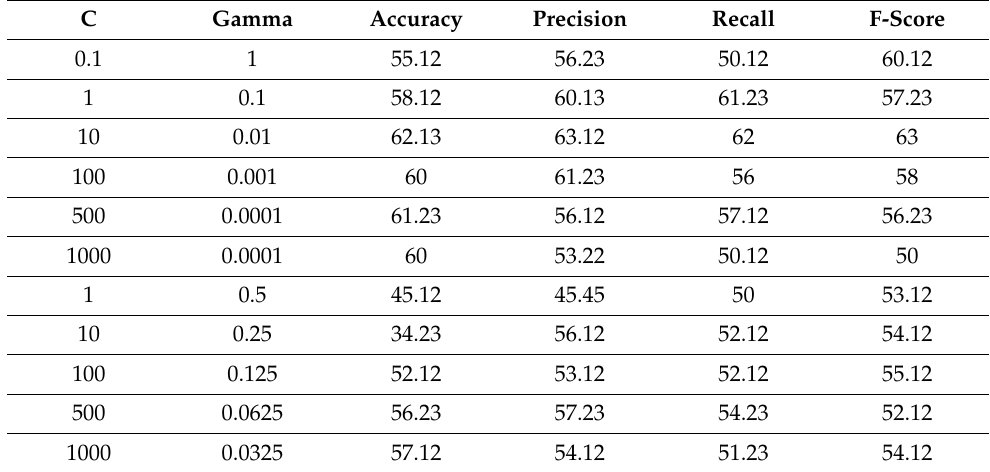
Table 1. SVM hyperparameter tuning.